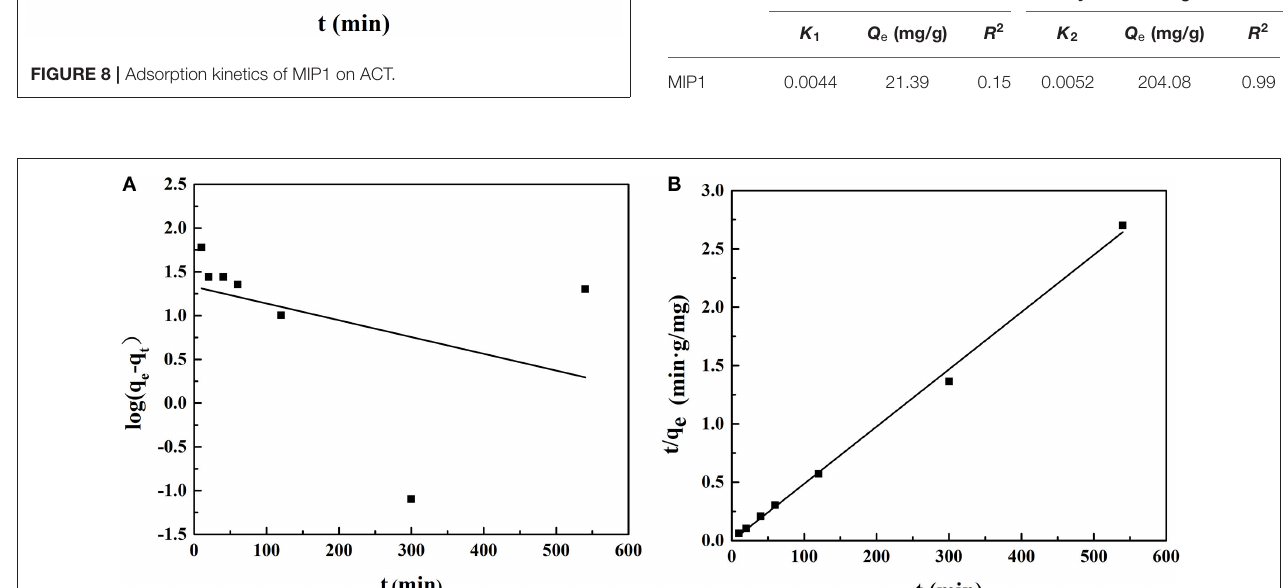
FIGURE 9 | Adsorption dynamic curves of ACT with the fitting to (A) the pseudo-first-order model and (B) the pseudo-second-order model.